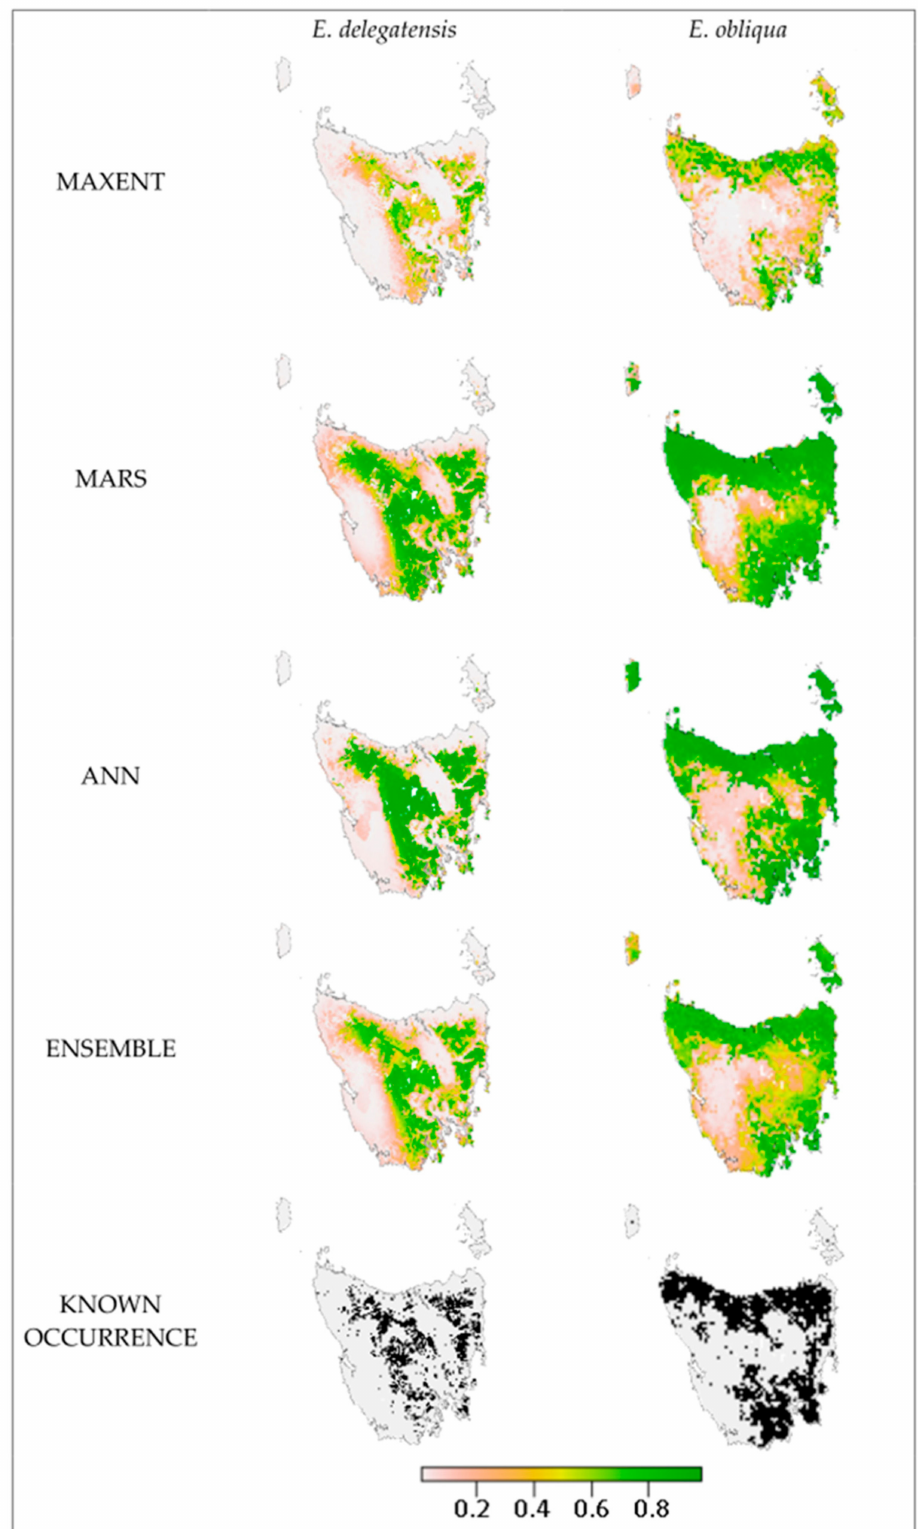
Figure 1. Environmental suitability for E. delegatensis and E. obliqua in Tasmania as modelled by SDM algorithms Maxent, multivariate adaptive regression splines (MARS) and artificial neural networks (ANN). The ensemble displays the mean of the three models. Black dots represent observed occurrence